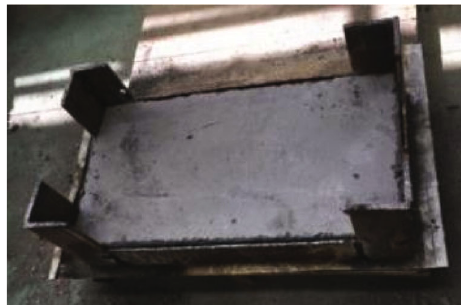
Figure 1: Complete layer specimen.